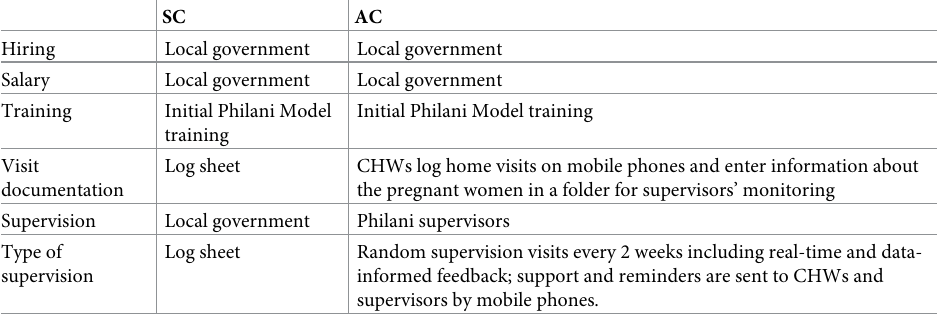
Table 1. Identification of responsibility for administrative and implementation functions of the CHWs and their